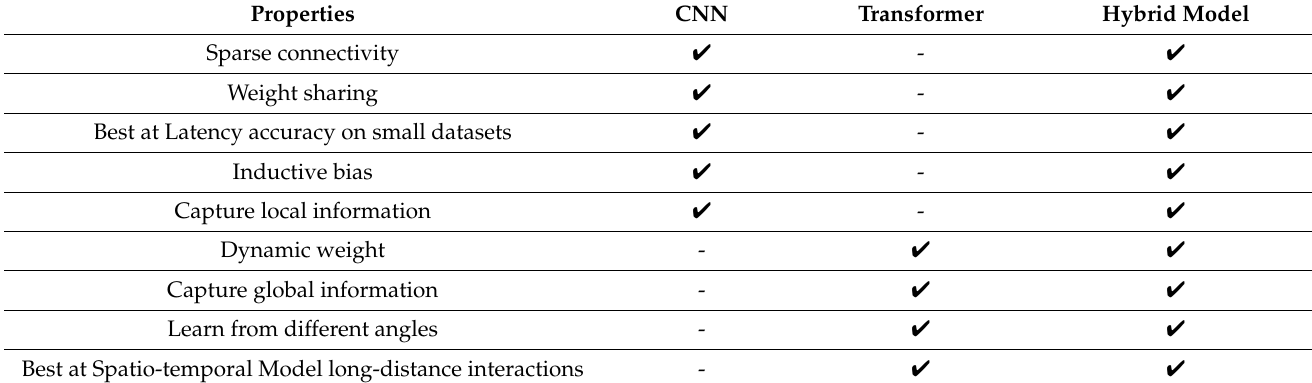
Table 1. CNN, Transformer, and hybrid model advantages, “-“indicates that the property is invalid in the